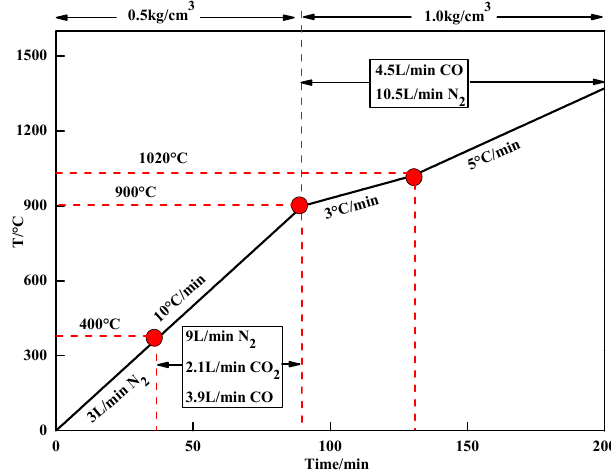
Figure 3. Experimental conditions for testing melting properties of sinter.